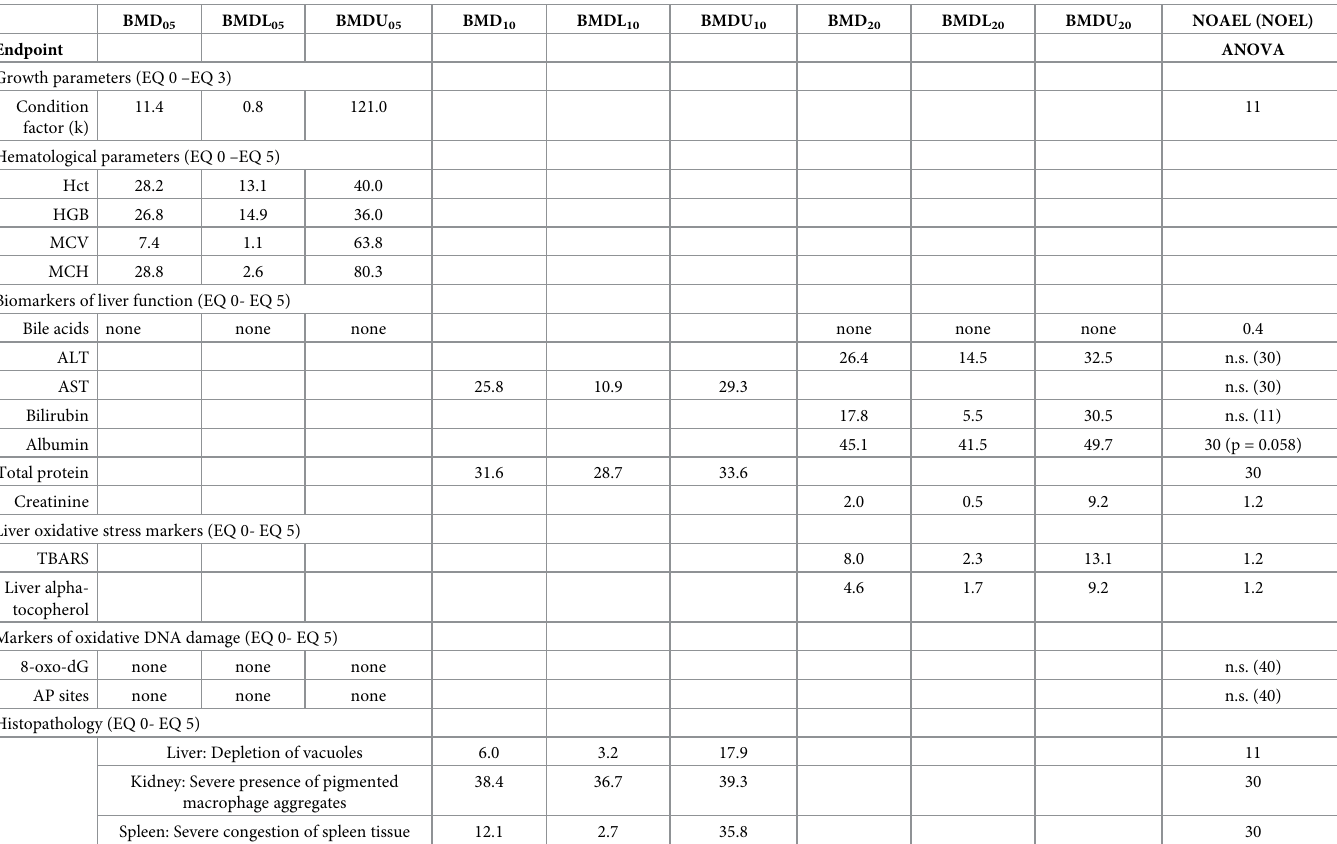
Table 7. Benchmark doses (BMD), lower and upper 90% confidence interval (BMDL and BMDU, respectively) and No Observed (Adverse) Effect Level (NOAEL/ NOEL) for relevant responses in Atlantic salmon ( Salmo salar L.) exposed to graded levels of ethoxyquin (EQ) through their diet for 90 day. Values are given in mg EQ/kg BW/day estimated from feed